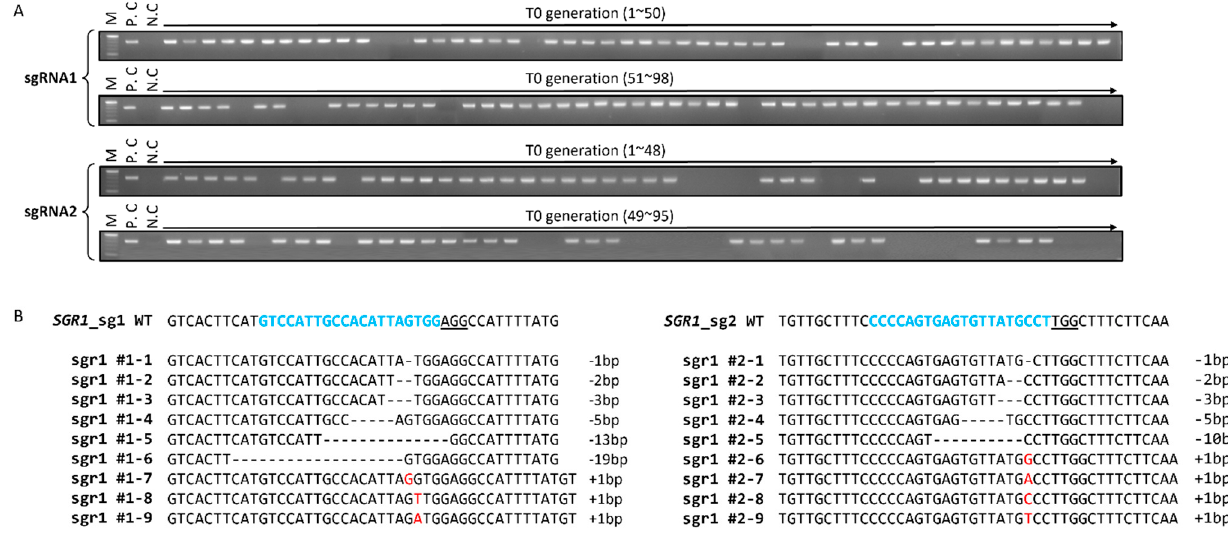
Figure 2. CRISPR/Cas9-induced mutation in SlSGR1 in tomato. ( A ) Confirmation of transformed plants via agarose gel electrophoresis with polymerase chain reaction (PCR) products amplified using the Ti-plasmid region from putative transgenic plants. ( B ) Deep-sequencing analysis of edited plants. Target DNA sequences of SGR1 _sg1 and SGR1 _sg2 are shown with the protospacer-adjacent motif (PAM) region in blue color on top of the aligned sequences. Deletions are indicated by dashes and insertions are indicated by red color. Indel sizes are shown on the right (+, insertion; − , deletion).